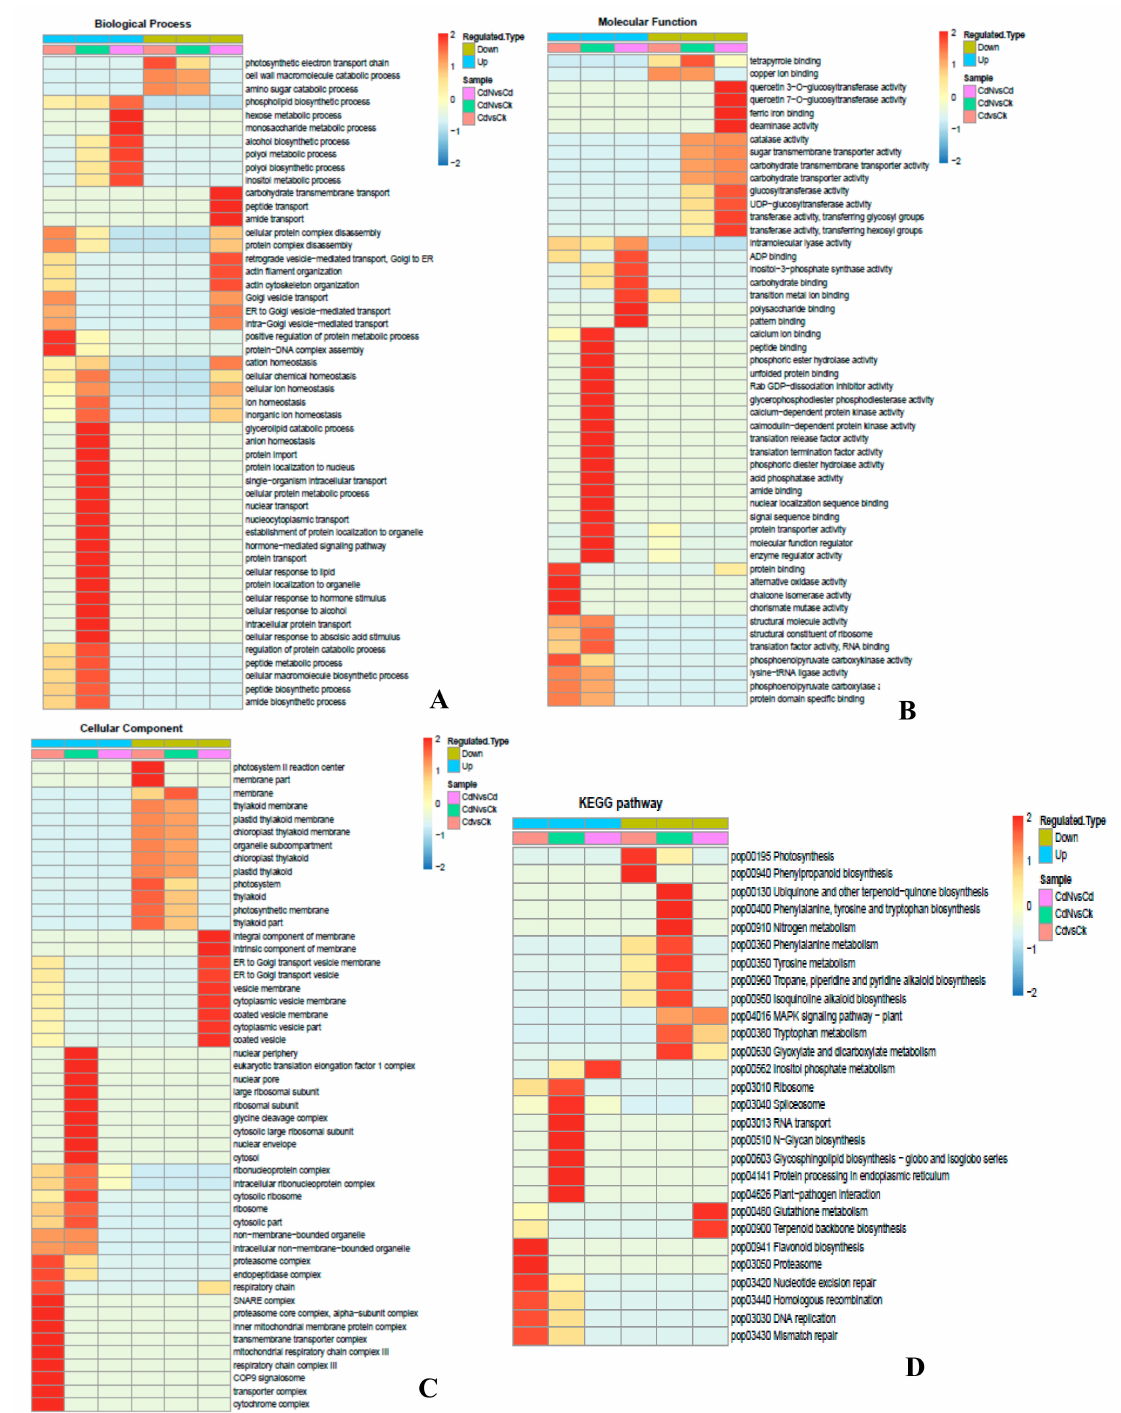
Figure 2. A comprehensive heatmap for cluster analysis of the enrichment patterns of di ff erentially expressed proteins up-regulated and down-regulated based on their Z-score (–log10 ( p -value); from –2 to 2). Cluster membership were visualized by a heat map using the heatmap.2” function from the “gplots” R-package. ( A ) A biological process category. ( B ) A molecular function category. ( C ) A cell component category. ( D ) A Kyoto Encyclopedia of Genes and Genomes (KEGG) pathway analysis for all di ff erentially expressed